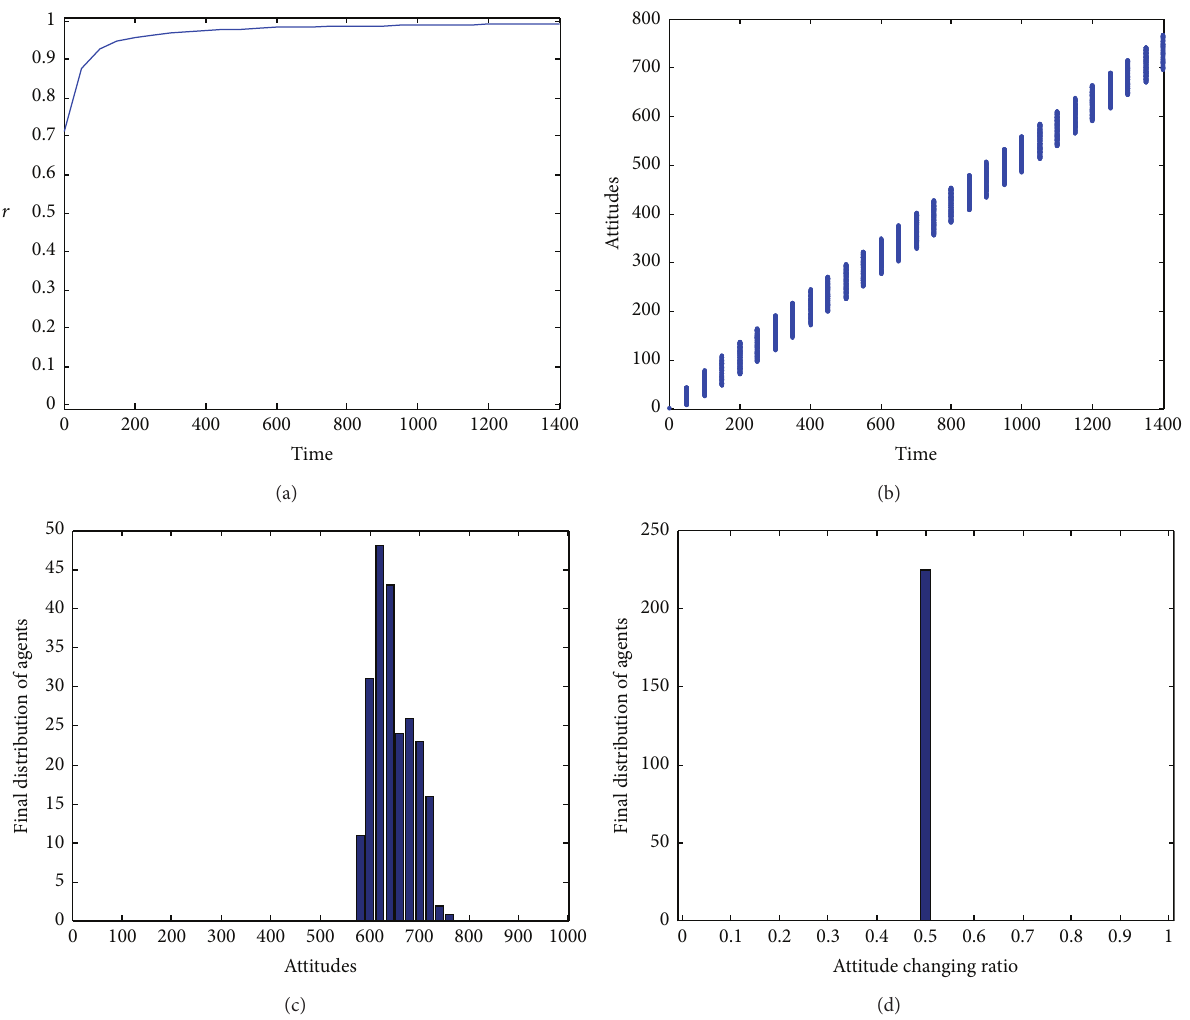
Figure 8: Results of simulation system with 𝐾 = 1.2 . (a) is the subfigure which shows synchronization criterion 𝑟 changes with time; (b) is the subfigure which shows group attitudes 𝑥(𝑡) versus time; (c) is the histogram of the final distribution of agents versus group attitudes 𝑥(𝑡) ; (d) is the histogram of the final distribution of agents versus attitude changing ratio ̇𝑥 𝑖 (𝑡) . ̇𝑋(𝑡) where is the average of ̇𝑥 𝑖 (𝑡) . Whether 𝑟 is close or equal to 1 explains whether the system achieves partial or complete